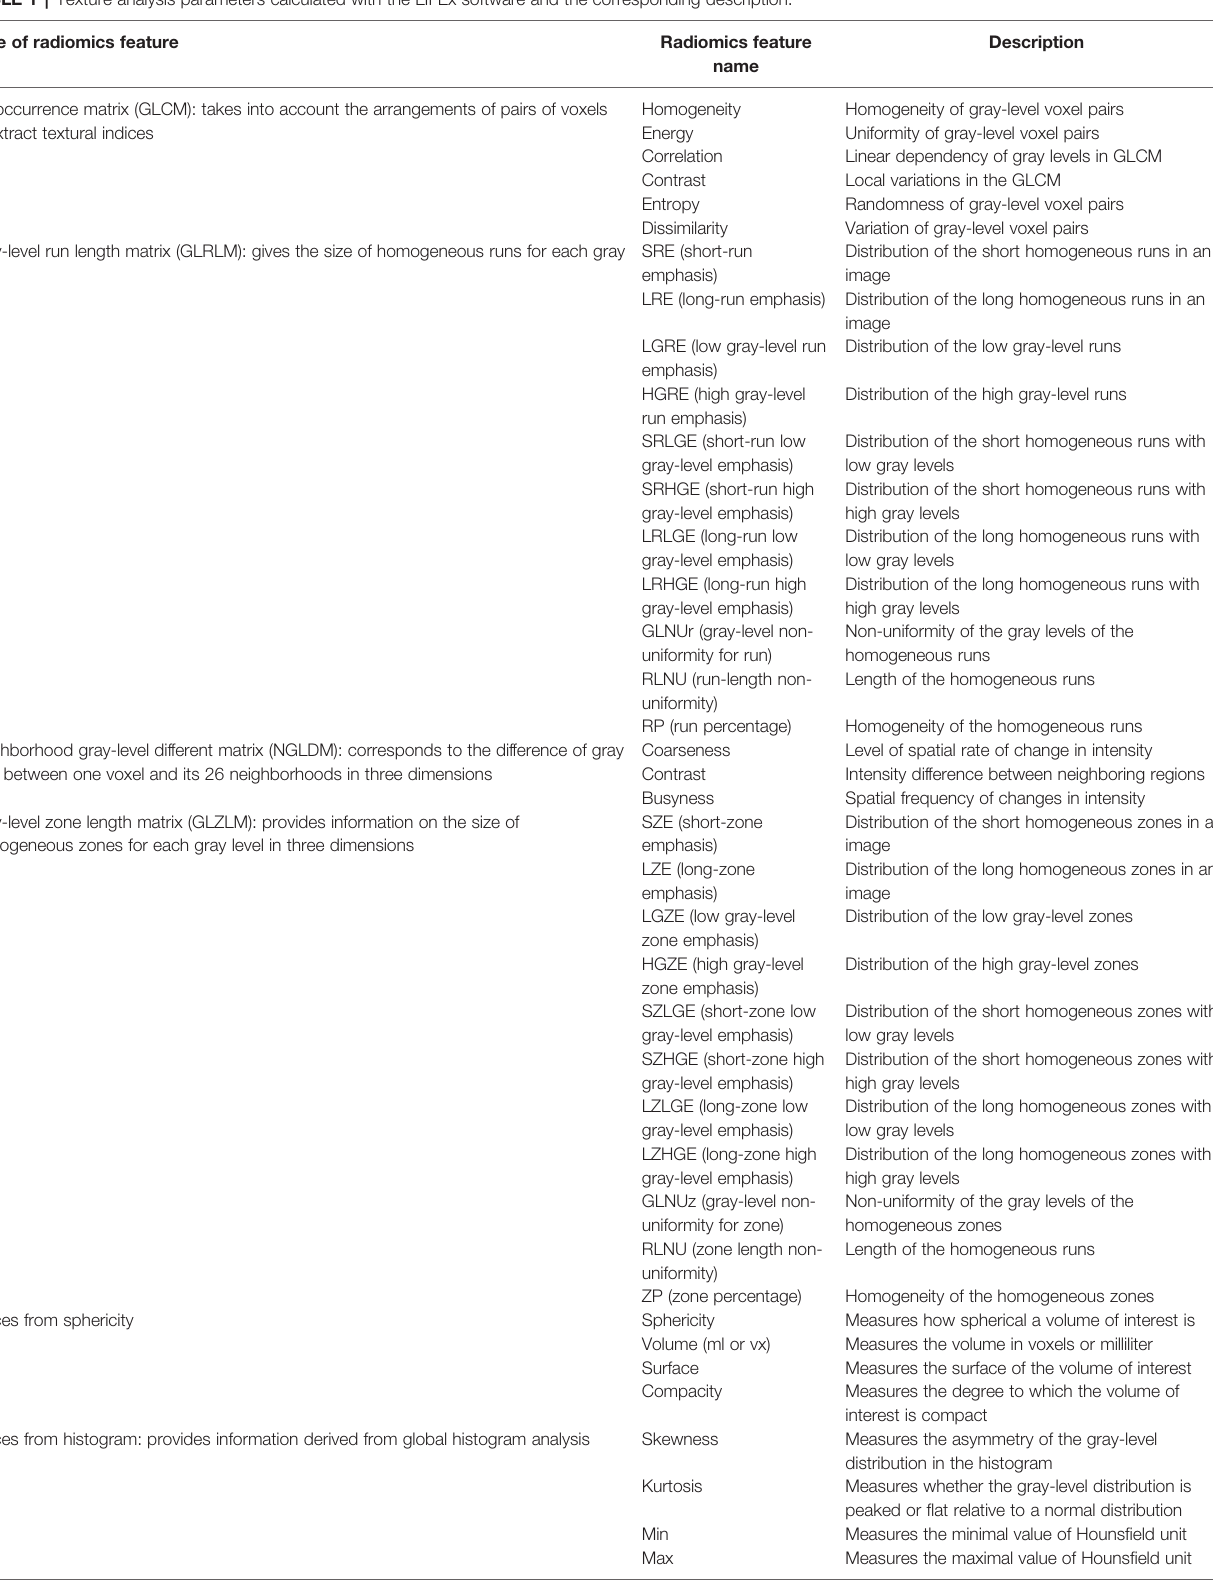
TABLE 1 | Texture analysis parameters calculated with the LIFEx software and the corresponding